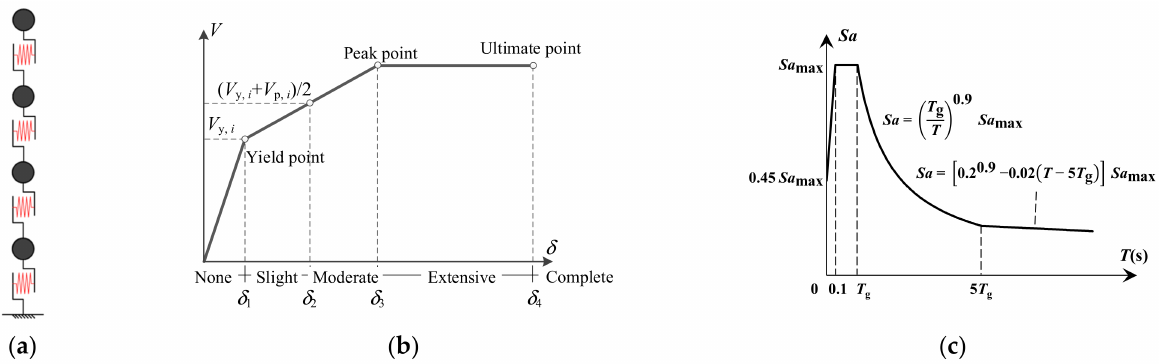
Figure 3. Building model: ( a ) MDOF shear model; ( b ) tri-linear backbone curve model; ( c ) design response spectrum of the Chinese code for the seismic design of buildings [22].